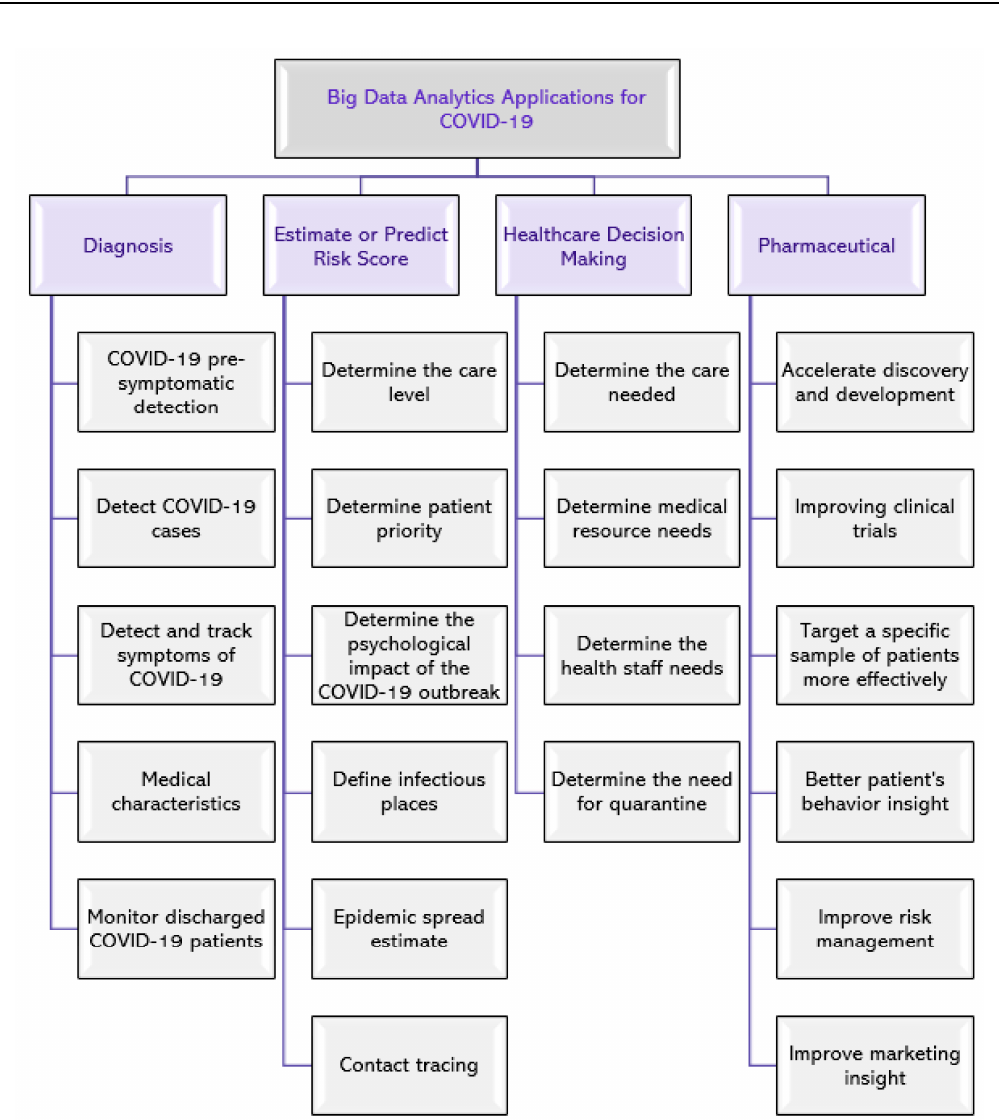
Figure 2. Possible usage of big data analytics in a number of different contexts for COVID-19 [28].